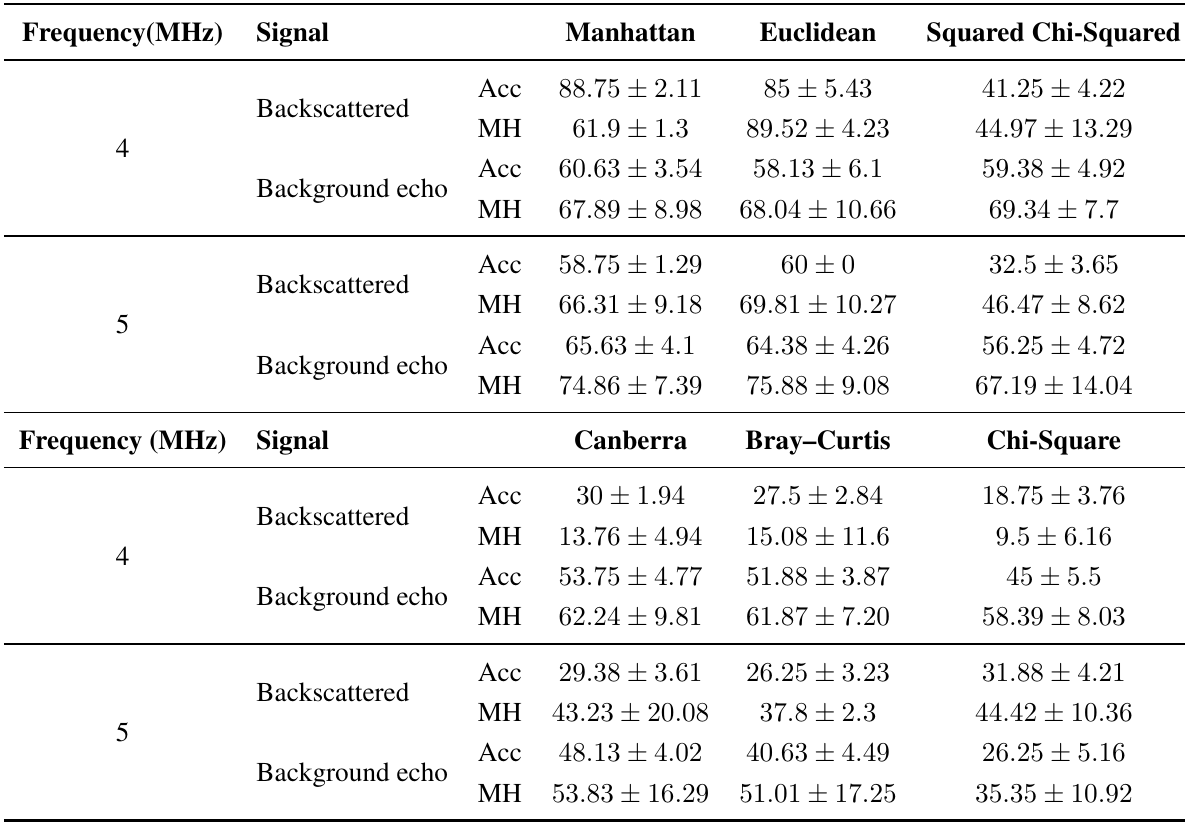
Table 1. Accuracy rate and harmonic mean for 4- and 5-MHz frequency signals at 650 ◦ C.